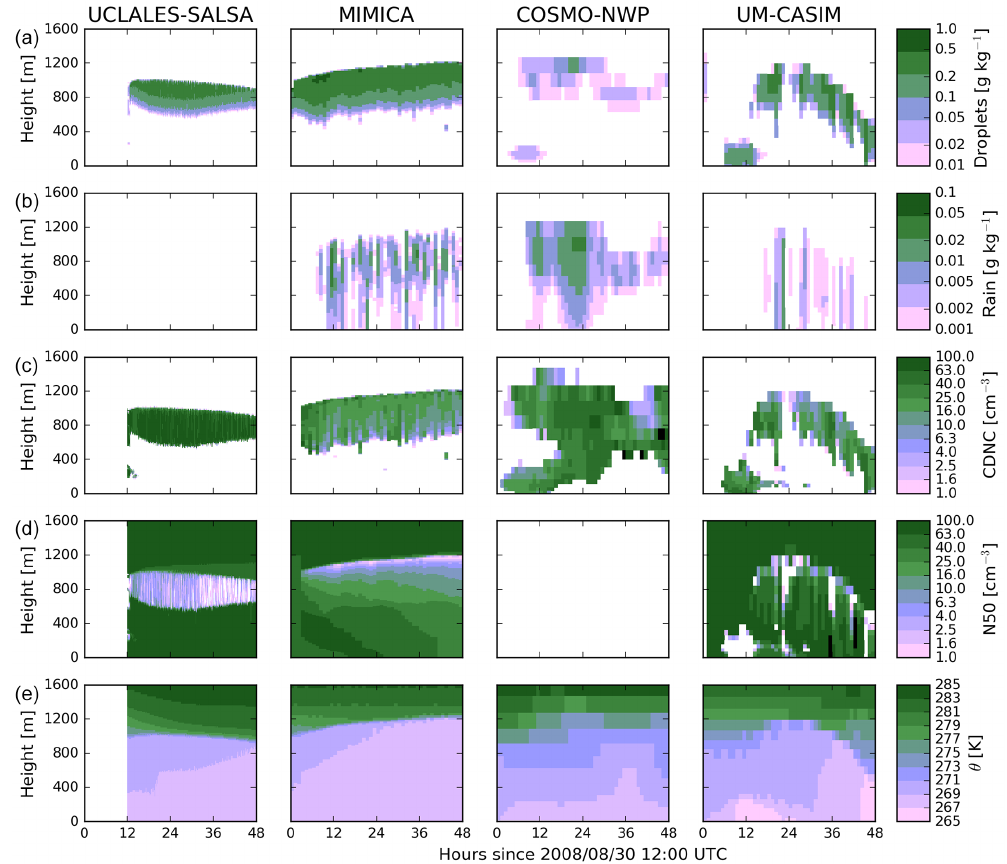
Figure 8. Cloud properties in the simulations with prognostic aerosol and an initial CCN concentration of 80cm − 3 (CCN80prog_NOICE). (a) Cloud droplet mass mixing ratio, (b) rain mass mixing ratio, (c) cloud droplet number concentration, (d) N50 concentration, and (e) po- tential temperature. Results are shown (from left to right) from the UCLALES-SALSA, MIMICA, COSMO-NWP, and UM-CASIM models. Note that aerosol concentrations and CDNCs are fixed during the 2h spin-up period in MIMICA, and N50 concentrations are not available for